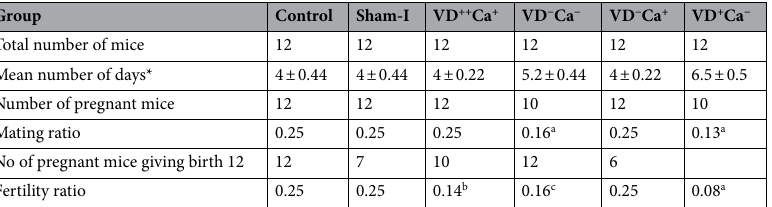
Table 1. Effect of vitamin D deficiency/overdose and calcium deficiency on mating and fertility rates. The groups were (1) control, (2) sham, (3) VD overdose and normo-calcemia (VD ++ Ca + ), (4) VD deficient and hypo-calcemia (VD − Ca − ), (5) VD deficient and normo-calcemia (VD − Ca + ) and (6) VD normal and hypo- calcemia (VD + Ca − ).In each group, 2 female mice were mated with 1 male mouse and the average number of days required for each mouse to become plug positive was recorded. The mating ratio is equivalent to number of animals multiplied by the average number of days required to become pregnant. The fertility ratio is equivalent to the number of pregnant females that give birth divided by the total number of mating days. Dunnett’s multiple comparisons test was used to analyze the significance of the fertility and mating rates . c p < 0.05, b p < 0.001, and a p < 0.0001. *Mean number of days ± standard